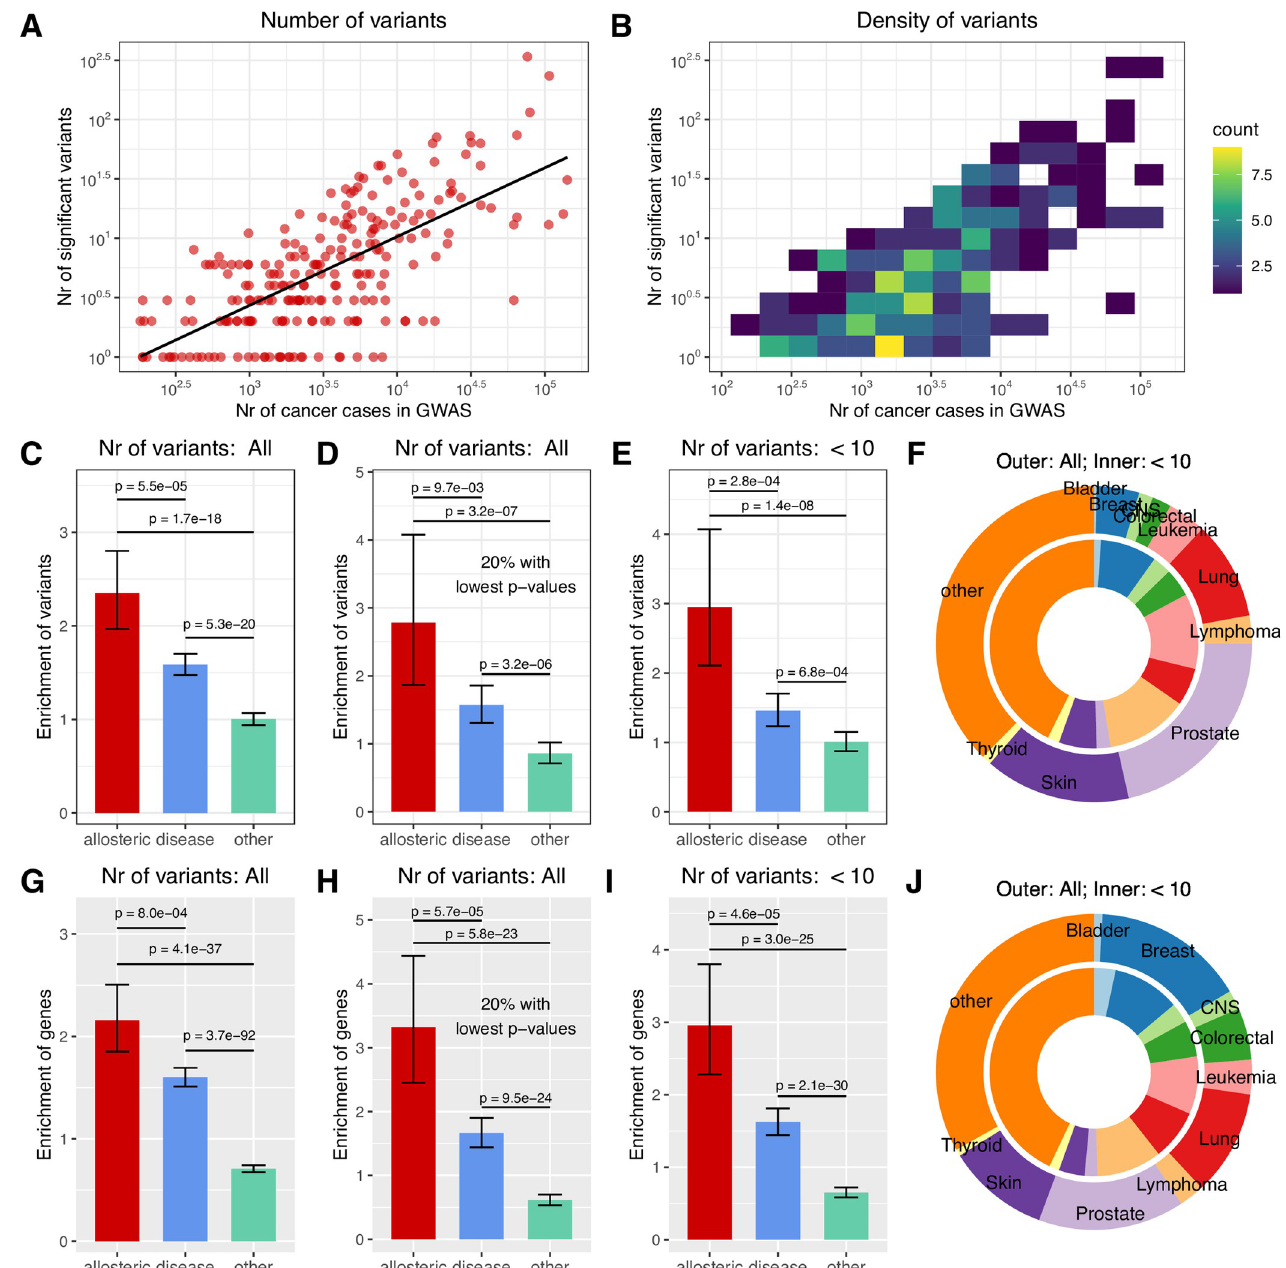
Fig 4. Variants of cancer GWAS are enriched near allosteric proteins. A-B ) Relationship between the number of cancer cases and significant variants (p < 10 − 8 ) in cancer GWA studies where at least one significant variant is located near a protein coding gene. The majority of GWAS have a moderate number of cases (and power), 10 3 − 10 4 , and identify less than 10 significant variants. Enrichment near different protein types was calculated in two datasets; one using studies irrespectively of the number of significant variants (“All”), and one using GWA studies reporting less than 10 significant variants, which is influenced less by the largest studies of the most common cancer types, and has less variability in statistical power to detect significant associations. C-F) In the analysis which only uses the studies with the highest number of cancer cases, allosteric and (mostly Mendelian) disease associated proteins show a 2- and 1.5-fold enrichment compared to other (i.e. neither allosteric nor disease associated) proteins (C). Variants with the highest significance in each GWAS (20% with the lowest p-values) show an even more pronounced, 3-fold enrichment near allosteric proteins (D). In studies reporting less than 10 variants, the enrichment near allosteric proteins is also 3-fold, comparable to the pattern seen with the most significant variants of the full dataset (E). The distribution of main cancer types in the variants of the two GWAS sets (F). G-J) The analysis which uses a single nonredundant list of genes compiled from all studies of the same cancer type (mapped trait of GWAS Catalog) shows a similar degree of enrichment of allosteric and disease proteins among the proteins identified by GWAS.